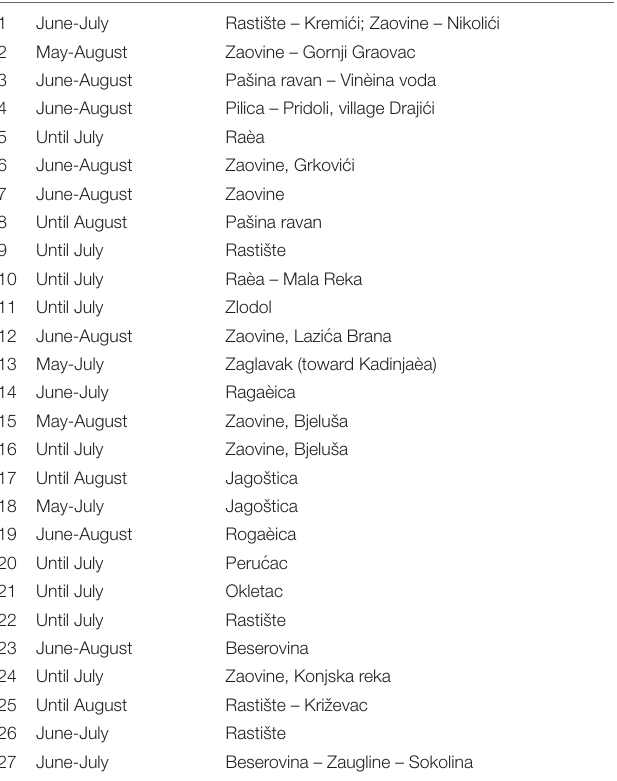
TABLE 1 | Data on 27 honey samples collected in 2019 from the Tara Mountain region in Serbia. No. Month of bee pasture Location of honeycombs on meadow